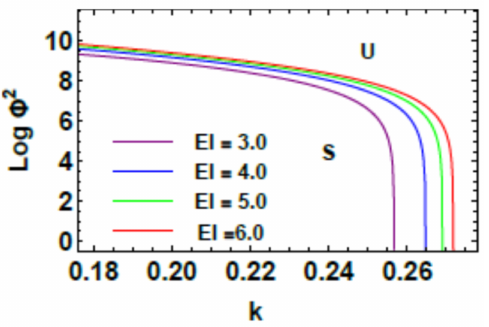
Figure 13. Plots of the stability bound for El for different values the parameter k versus Log Φ 2